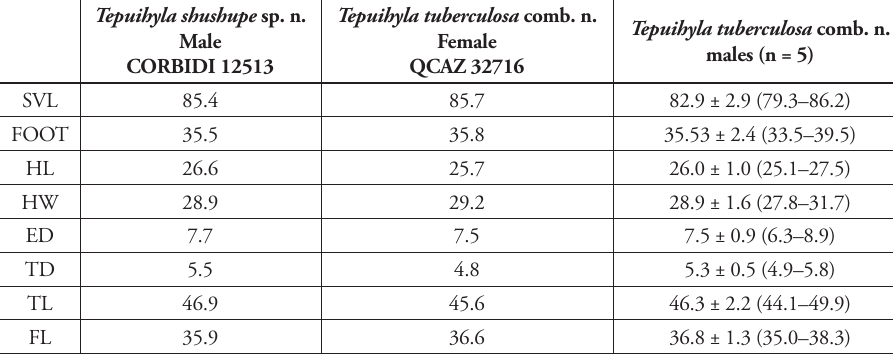
Table 5. Descriptive statistics for measurements of adult Amazonian Tepuihyla . Mean ± SD is given with range in parenthesis. Abbreviations are: SVL = snout-vent length; FOOT = foot length; HL = head length; HW = head width; ED = eye diameter; TD = tympanum diameter; TL = tibia length; FL = femur length. All measurements are in mm. Tepuihyla shushupe sp.